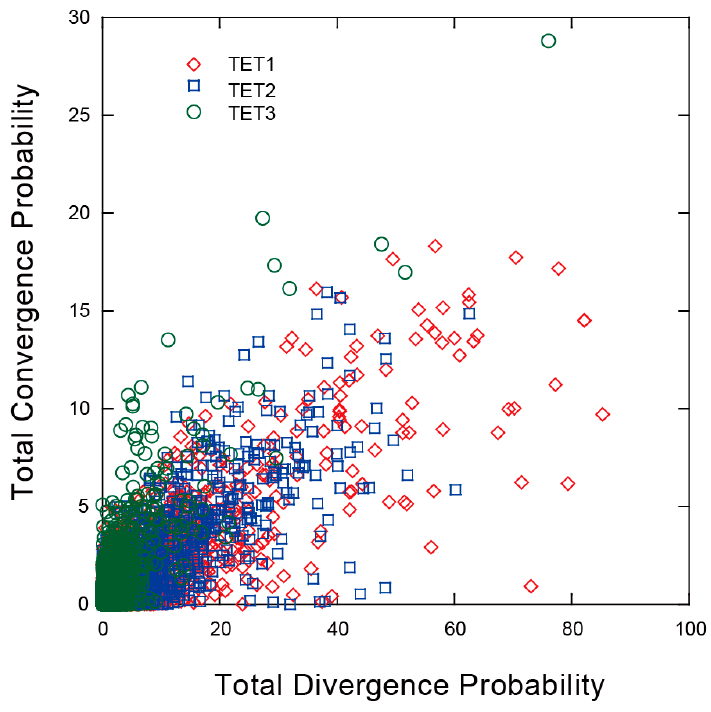
Figure 4. Total posterior probabilities of divergence vs. total posterior probabilities of convergence for all pairs of branches in the TET gene tree. TET1 pair-wise branch comparisons (red), TET2 pair-wise branch comparisons (blue) and TET3 pair-wise branch comparisons (green).